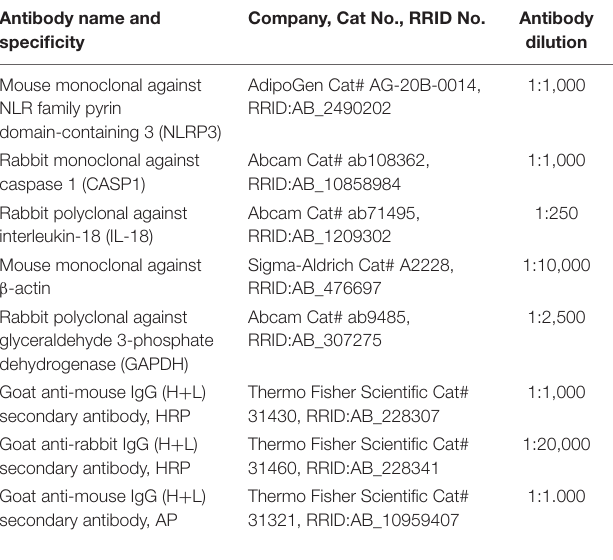
TABLE 1 | Specification of antibodies used for Western